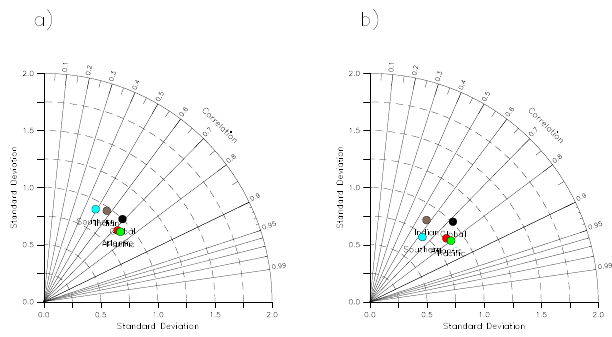
Figure 14. Taylor diagrams of model–observation comparisons for surface chlorophyll (log10-transformed) using monthly mean fields (a) and annual-mean fields (b) . Black dot corresponds to global comparison; red dot to the Atlantic Ocean, green dot to the Pacific Ocean, brown dot to the Indian Ocean and gray dot to the Southern Ocean (south of 45 ◦